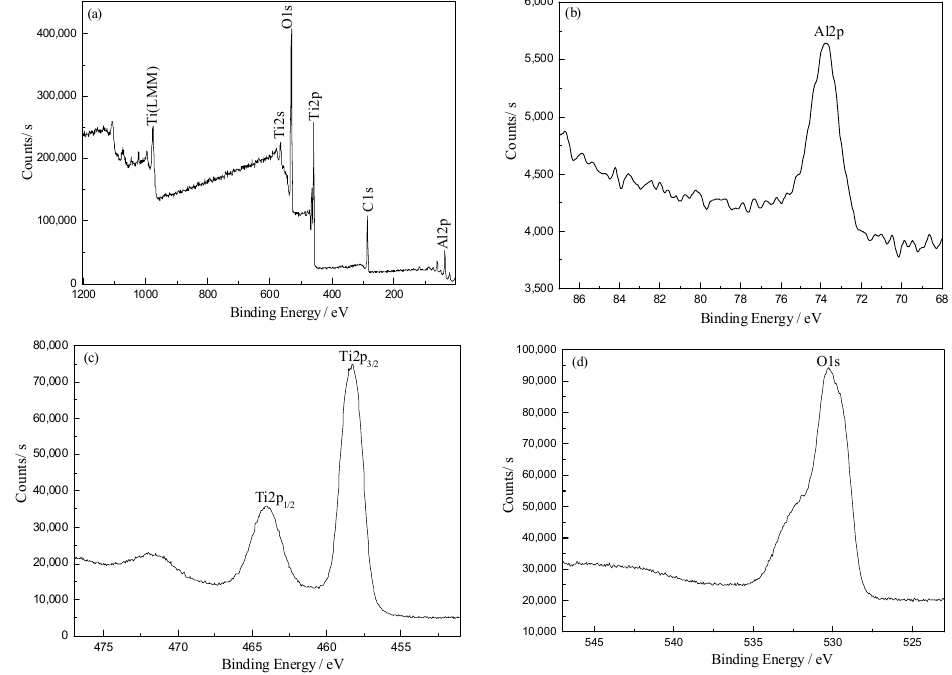
Figure 1. X-ray photoelectron spectroscopy of No. 4 sample: ( a ) Full spectrum; ( b ) Al2p peak; ( c ) Ti2p peak; ( d ) O1s peak.